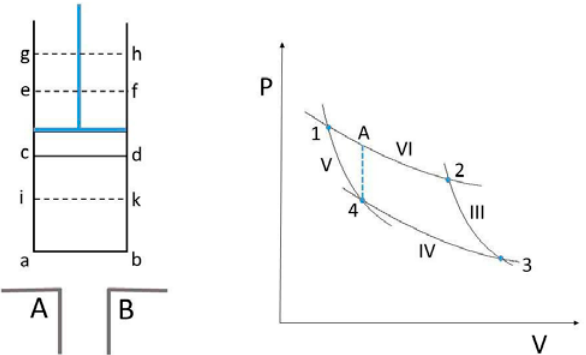
Figure 5. (a) the Carnot cycle as shown in the original drawing; (b) the usual representation of the Carnot cycle for a gas on the p-V diagram. Points A and 4 correspond to the initial volume and to completion of the isothermal